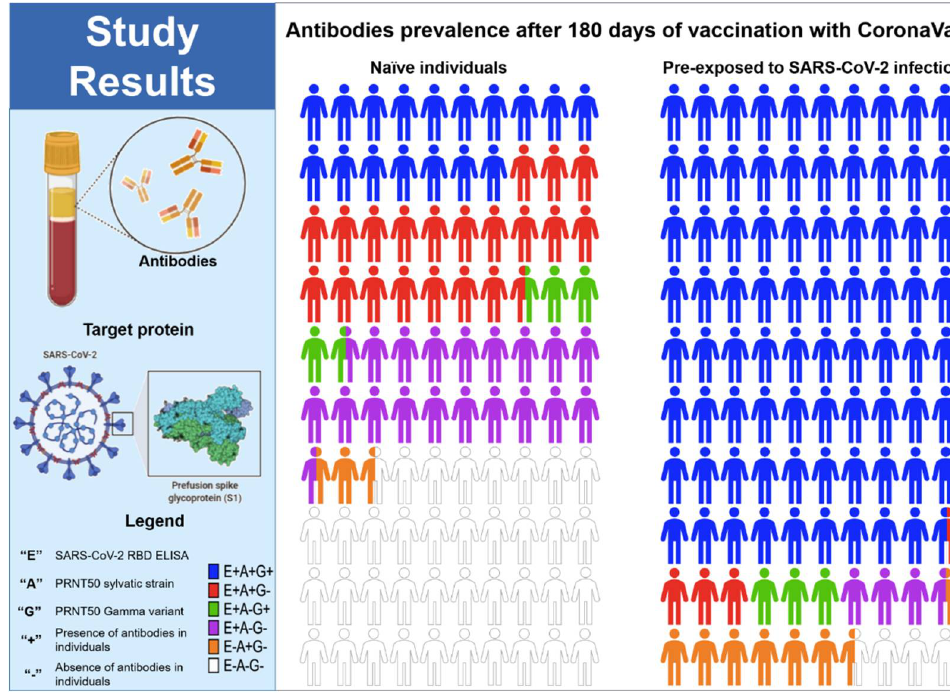
Figure 5. Parts of whole RBD specific and neutralizing antibodies in naïve individuals and individuals pre-exposed to SARS-CoV-2 infection after 180 days of the vaccination with CoronaVac. (+) presence of antibodies in the individuals, (-) absence of antibodies in the individuals, (E) SARS-CoV-2 RBD ELISA, (A) PRNT50 with the B.1.1.33 variant, and (G) PRNT50 with the Gamma variant.